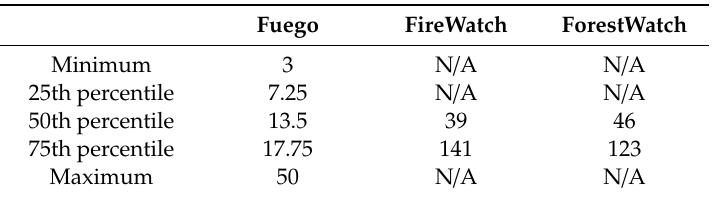
Table 4. Detection delay in